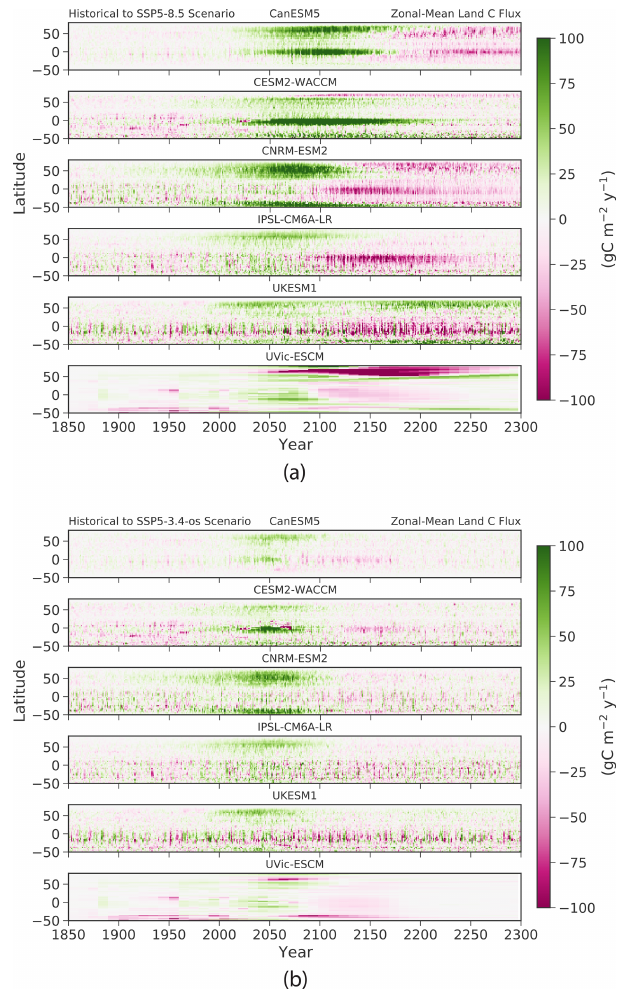
Figure 5. Zonal mean terrestrial carbon flux dynamics of the six models under (a) the SSP5-8.5 and (b) SSP5-3.4-overshoot scenar- ios. Positive flux represents a net carbon